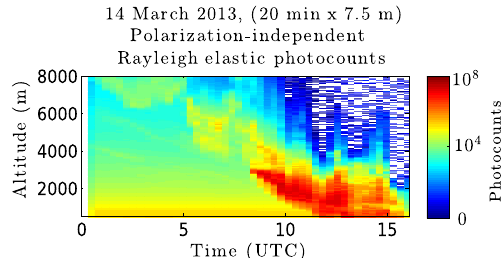
Figure 14. Context plot of all individual Y(z) values for 14 March 2013. Box A indicates the region included in the nightly profile which includes all measurements. The profiles from this selection are given in Fig. 15a. Box B indicates the region included in the nightly profile which excludes any regions with thick clouds. This clear-sky region has profiles given in Fig. 15b.